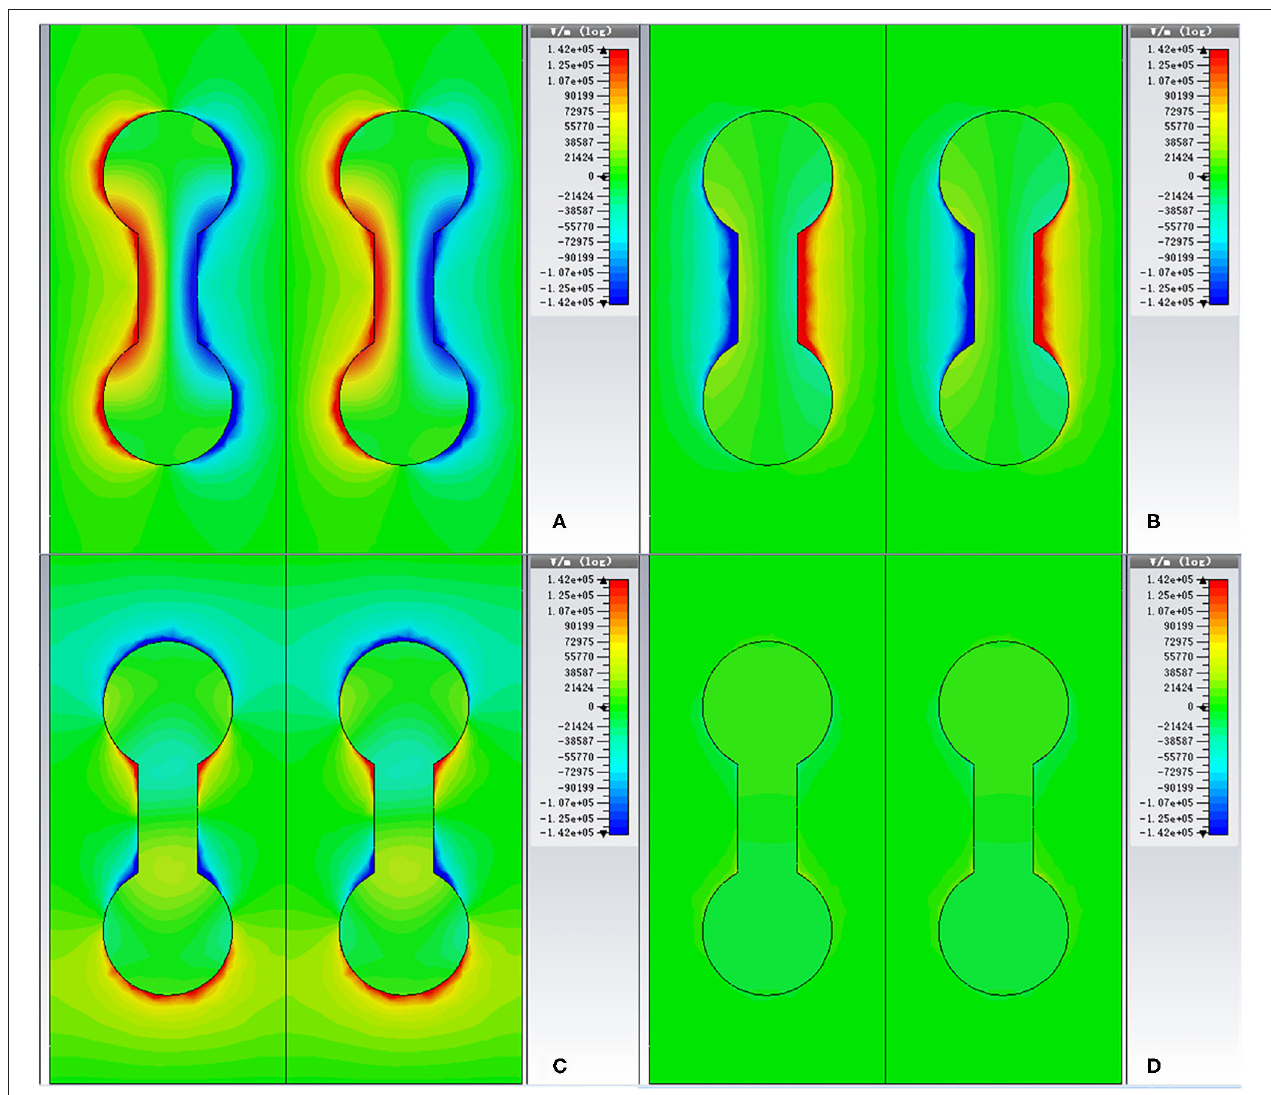
FIGURE 3 | Induced electric field distributions of the dumbbell-shaped graphene absorber for different modes: (A) TM for 0.5302 THz; (B) TM for 0.2242 THz; (C) TE for 0.5302 THz; (D) TE for 0.2242 THz.